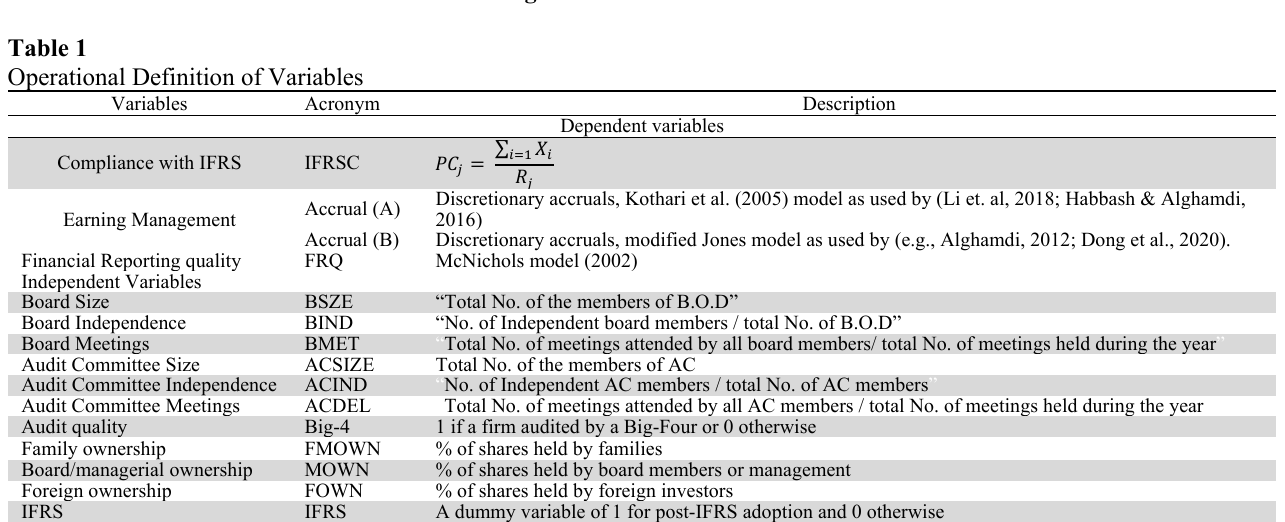
Fig. 1. Research framework